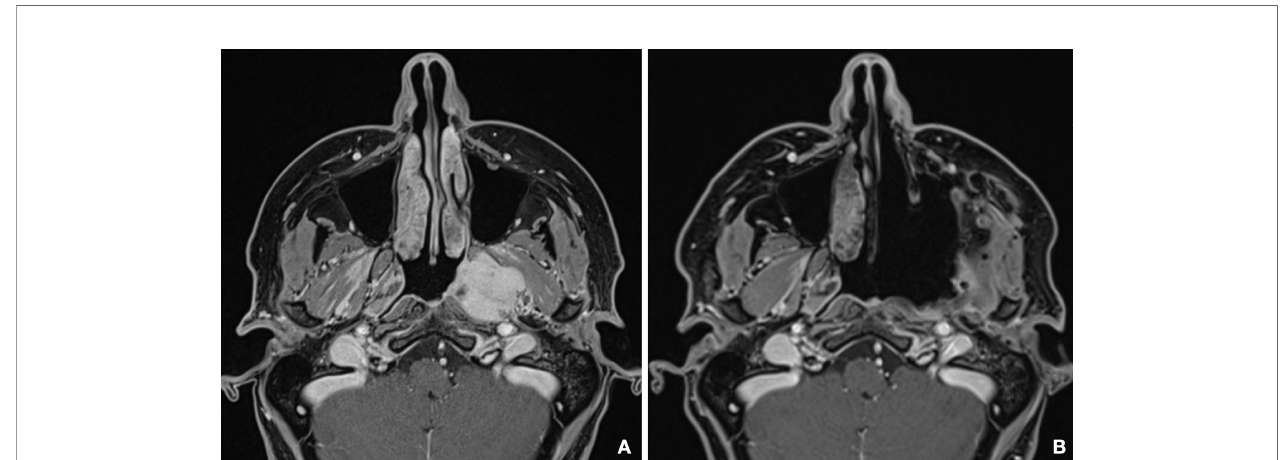
FIGURE 8 | Comparison between preoperative (A) and postoperative (B) MR shows the complete emptying of the PMPF and macroscopically radical excision of the